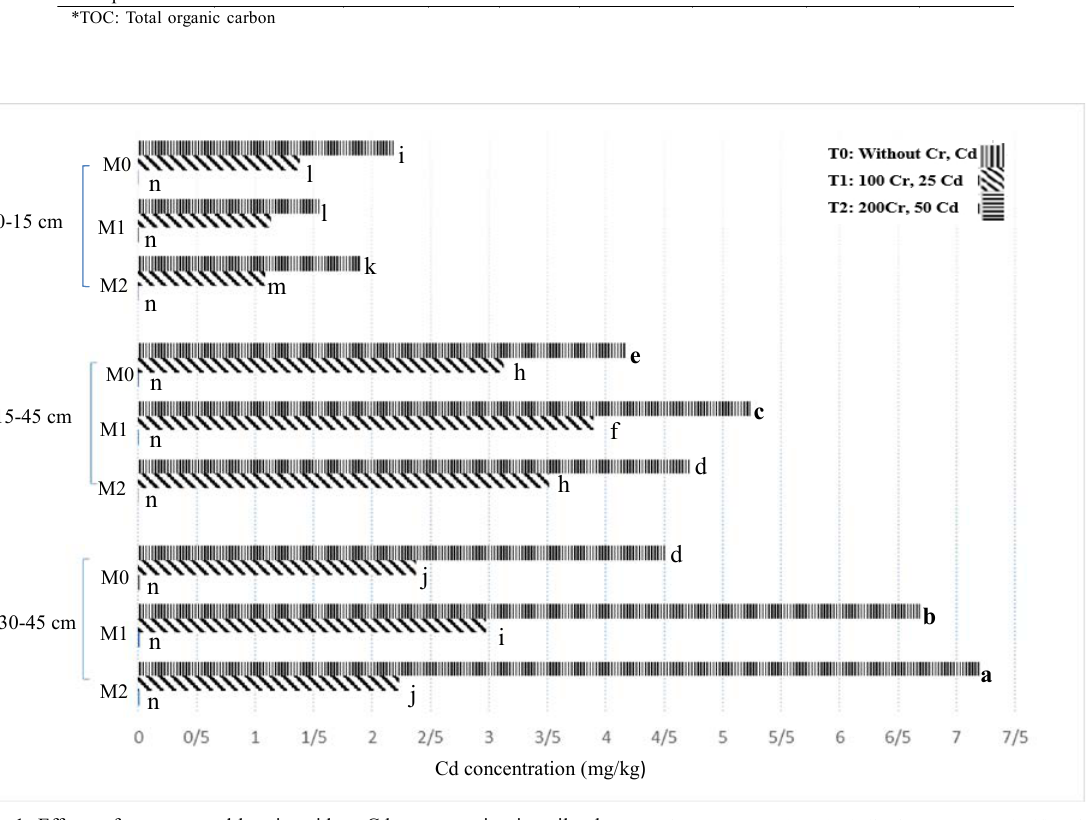
Fig. 1: Effects of compost and humic acid on Cd concentration in soil column. Values are means (n = 3) Similar letters are not significantly different at P<0.05 , according to Duncan’s test. M0: without organic substance, M1: compost, M2: Humic